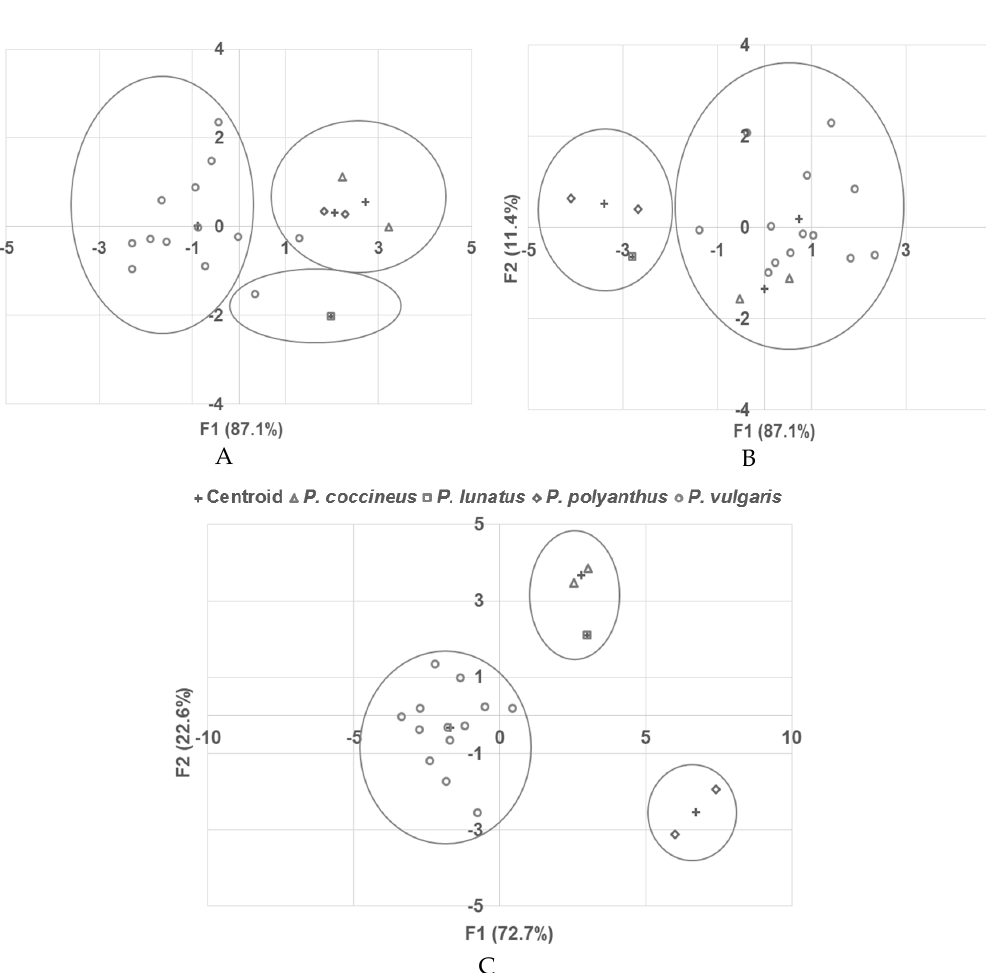
Figure 6. Discriminant analysis of the Phaseolus species collected in the Mayan region: ( A ) Phenolic compounds and antioxidant activity, ( B ) antinutritional components, and ( C ) phenolic compounds, antioxidant activity, protein content, and antinutritional components.